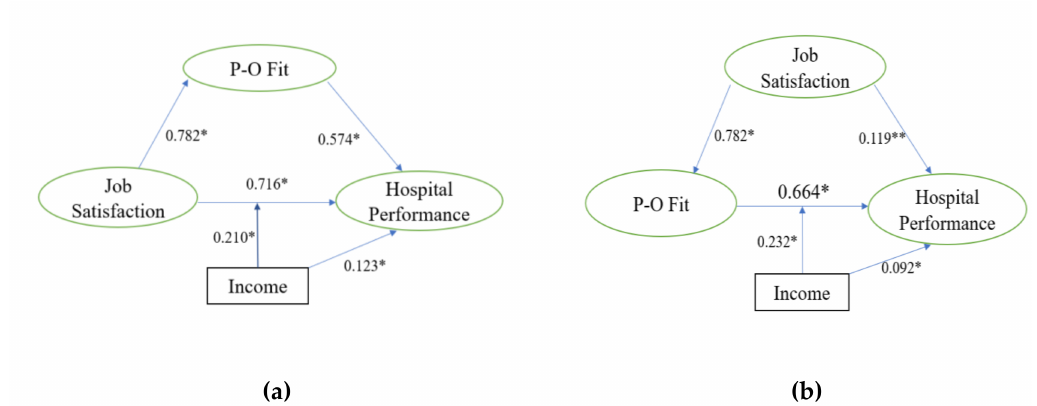
Figure 2. Income as a moderator on the e ff ects of job satisfaction and P-O fit (Person-Organization fit) on hospital performance. ( a ) Moderating e ff ect of income on “Job satisfaction → Hospital performance”: t = 4.080, p < 0.001. * p < 0.05. ( b ) Moderating e ff ect of income on “P-O fit → Hospital performance”: t = 3.693, p < 0.001. * p < 0.05, ** p <